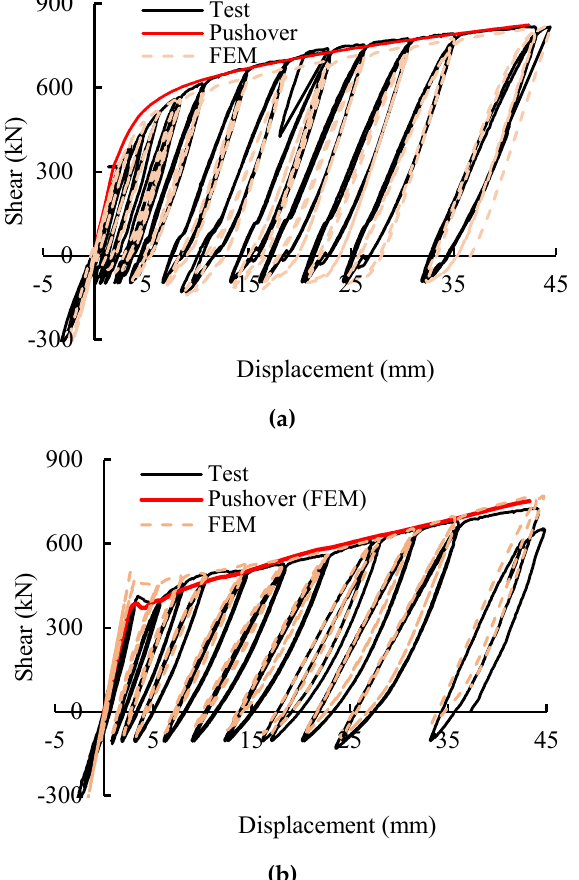
Figure 8. Comparison of the simulation and test results for specimens ( a ) C and ( b ) D. (Adapted with permission from Ref. [22]. Copyright 2022 Springer Nature.)